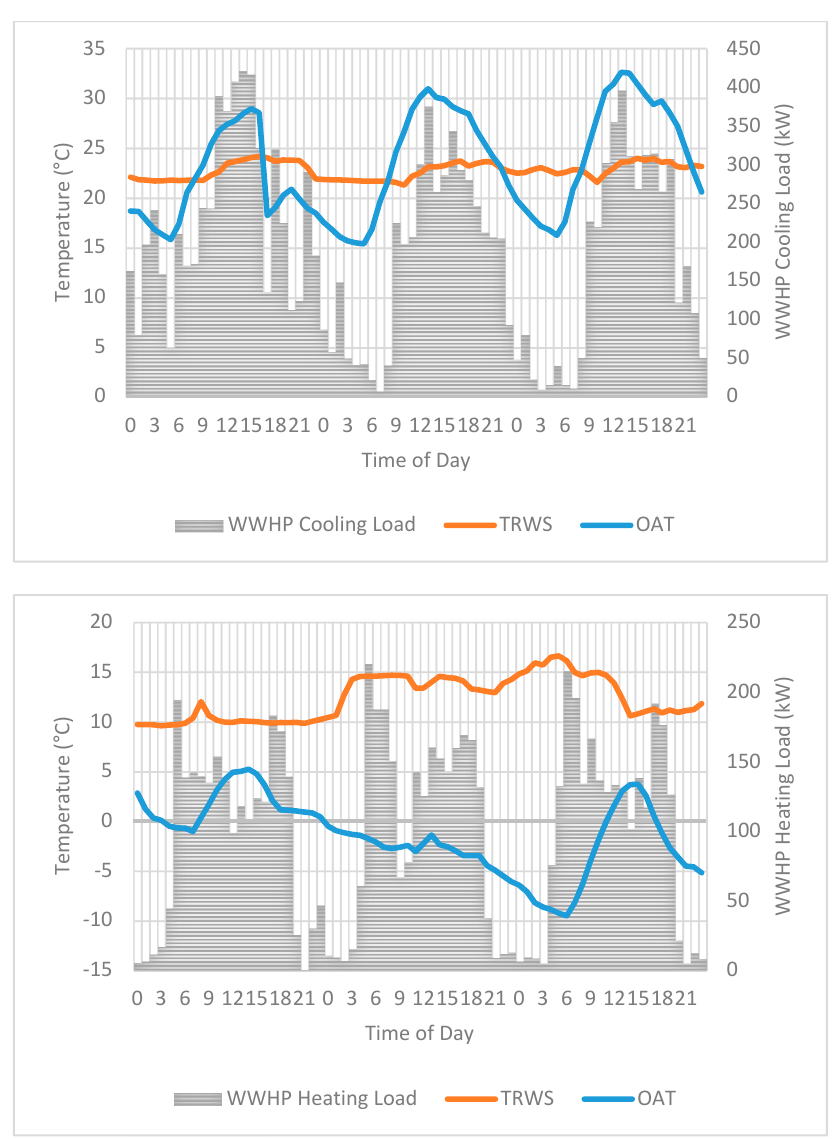
Figure 3. Outdoor air (OA) dry bulb temperature, recycled water (RW) temperature, and water-to-water heat pump (WWHP) loads during typical days in the cooling season ( top ) and heating season ( bottom ).